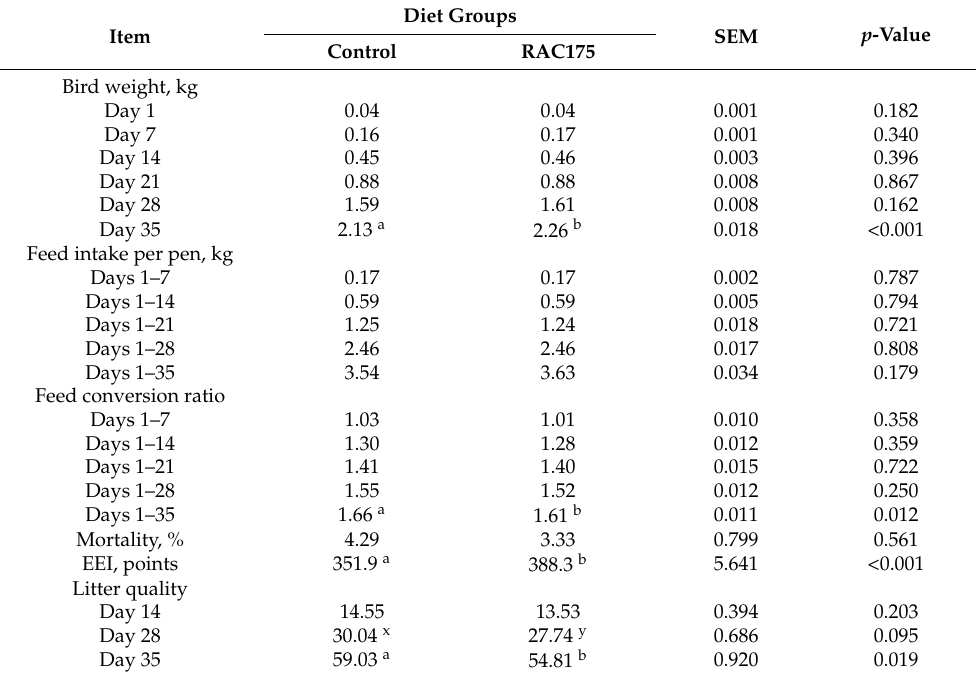
Table 7. Results of Trial